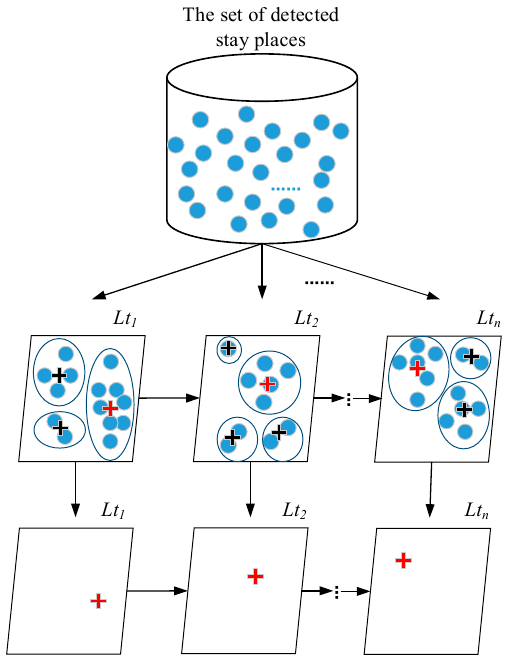
Figure 6. The hierarchical graph of optimal stay-place sequence detection.